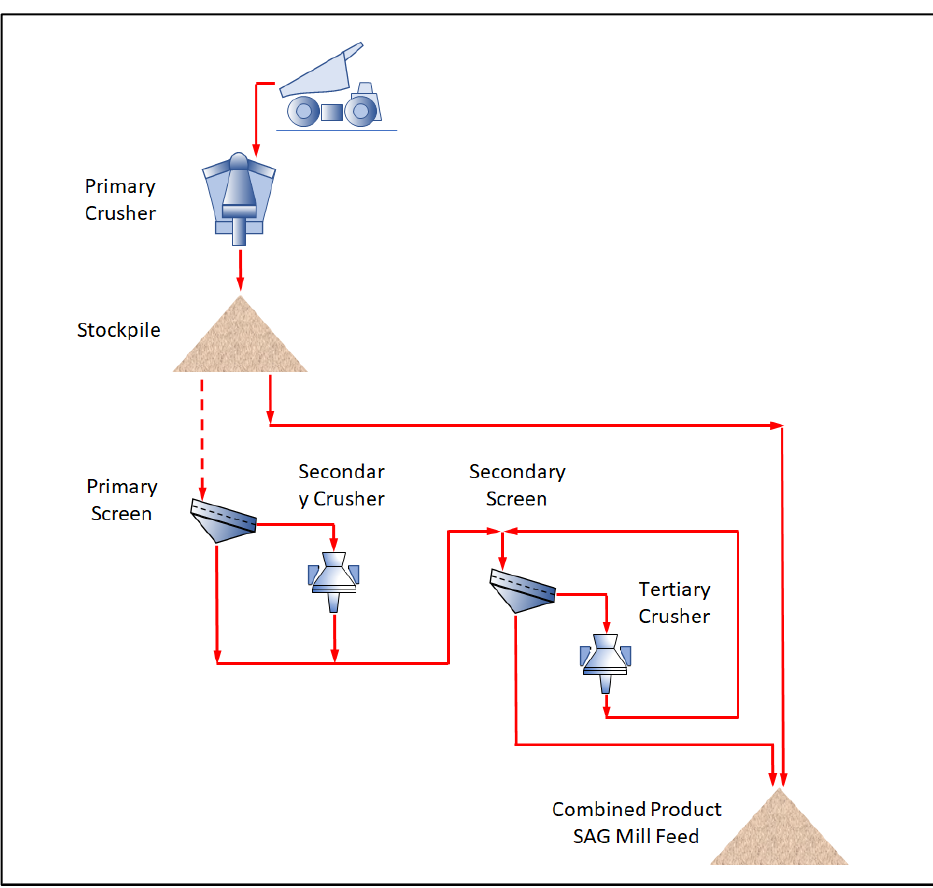
Figure 5. Cristalino crushing circuit.